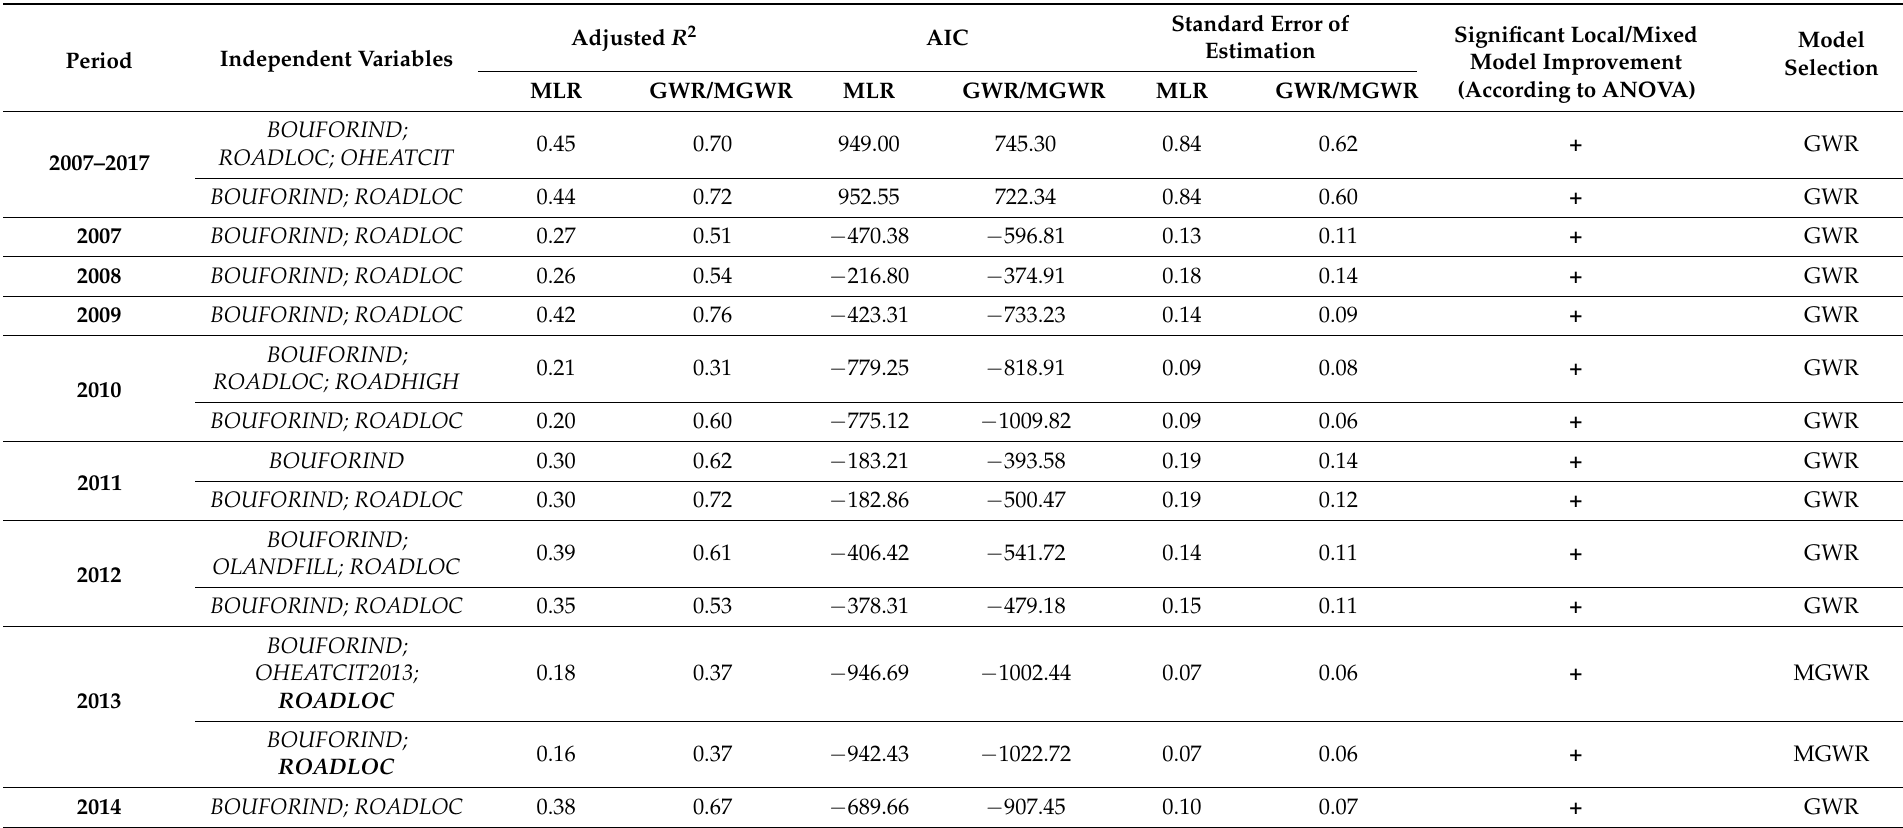
Table 3. Comparison of global multivariate linear regression (MLR) models and local (GWR) or mixed (MGWR) geographically-weighted regression models. The sign “( − )” before the variable name means that the variable is negatively correlated with a dependent variable, stationary variables in MGWR are in bold. The order of variables illustrates the order of entry into the MLR model (stepwise regression with forward selection). The sign “(+)” means the improvement GWR/GWMR model compared to MLR model.